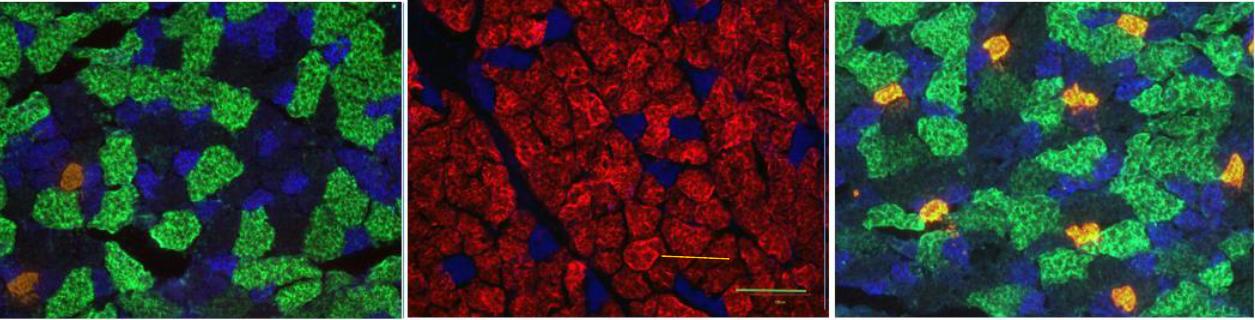
Figure 4. Representative immunofluorescent staining of myofibers. The first panel is an EDL muscle, the middle panel is of the soleus muscle, and the third panel is of plantaris muscle. In each muscle portrayed, Type I fibers are identified with AlexaFluor 555 (red), Type IIA fibers are stained with Alex- aFluor 350 (blue), Type IIB fibers are identified with AlexaFluor 488 (green), while unstained fibers (with cell borders still visible) are those of the Type IIX category. Scale bar in center panel = 100 µ